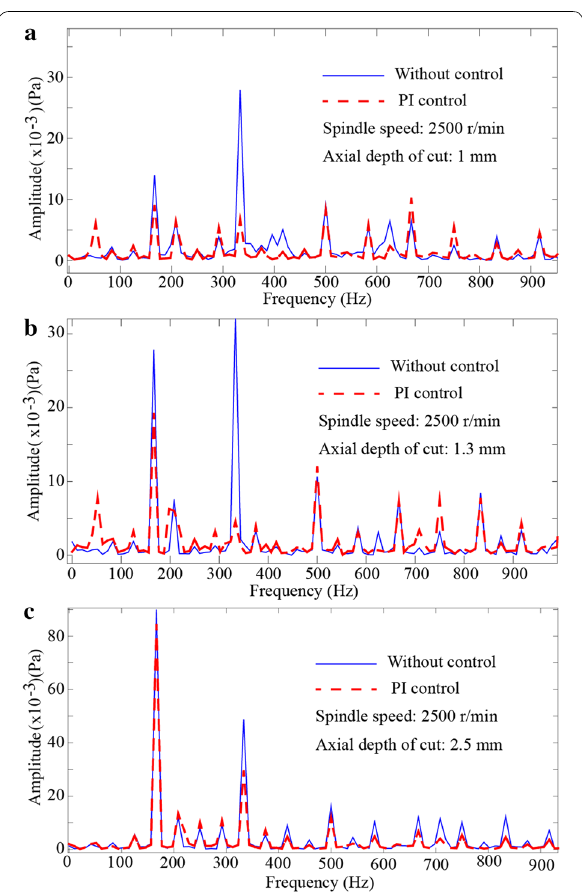
Figure 7 FFT of displacement signals at a spindle speed of 2500 r/min: ( a ) at an axial depth of cut of 1 mm, ( b ) at an axial depth of cut of 1.3 mm, and ( c ) at an axial depth of cut of 2.5